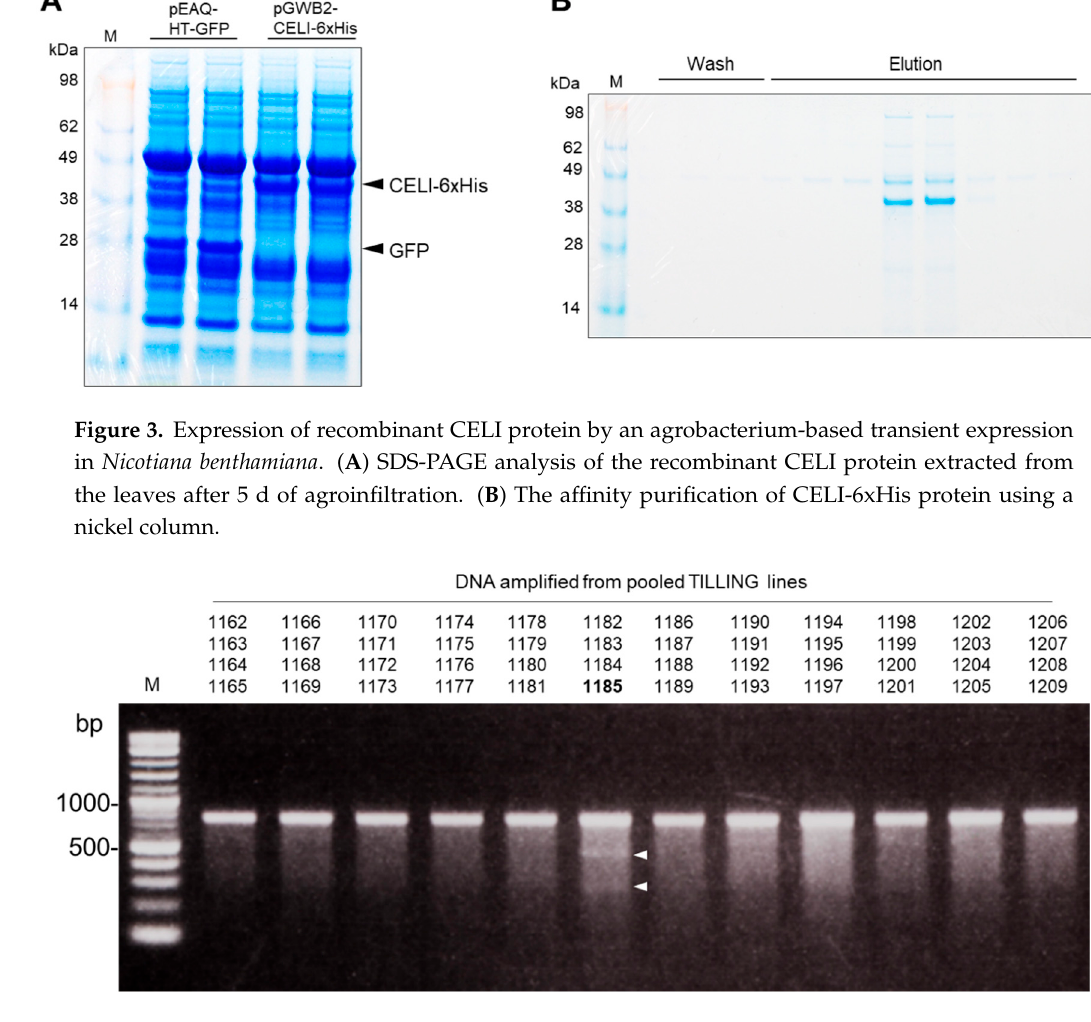
Figure 4. Detection of a mutation in the Waxy gene by cleavage of heteroduplex DNA using the purified recombinant CELI endonuclease. The Waxy gene fragments amplified from mixed genomic DNA of four individual TILLING lines around EUM1185 were treated with the recombinant CELI protein. Arrowheads indicate two cleaved bands derived from EUM1185.